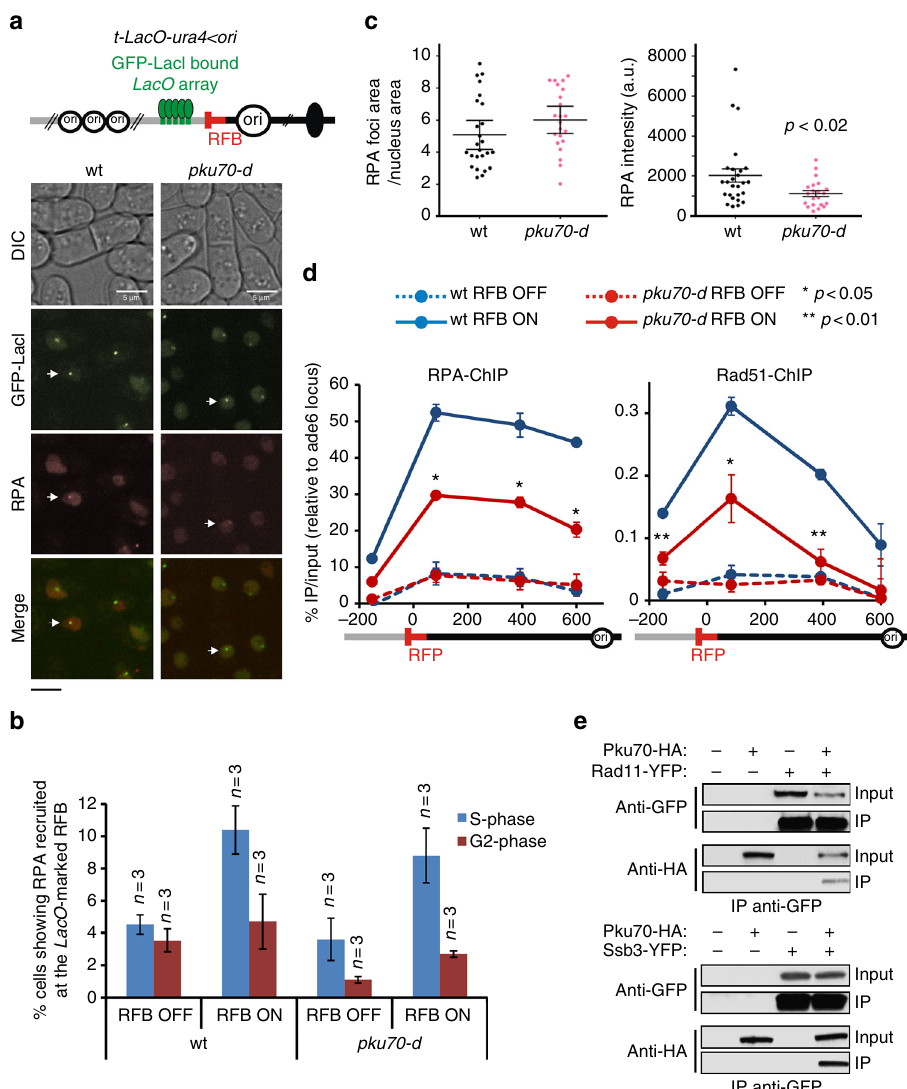
Fig. 7 The lack of Ku impairs RPA and Rad51 recruitment to terminally arrested forks. a Top panel: scheme of the LacO -marked RTS1 -RFB. Bottom panel: representative images showing RPA (labelled with Ssb3-mCherry) recruitment to the LacO -marked RFB. Of note, to avoid biases toward a random localization of GFP-LacI and RPA foci, cells with ≥ 3 RPA foci were excluded from the analysis. Scale bars correspond to 5 µ m. b % of cells showing RPA recruitment to the LacO -marked RFB, according to cell cycle phase. G2 and S-phase cells are mononucleated cells and bi-nucleated cells with a septum, respectively. Values are means of n samples from independent biological replicates ± SD. c Area and intensity of RPA foci recruited to the LacO -marked RFB. Each dot represents one RPA foci in S-phase upon RFB activation. Bars indicate the mean value ± 95% CI. Statistics were calculated using the non-parametric Mann-Whitney U test. d Analysis of RPA and Rad51 recruitment to the RTS1 -RFB by ChIP-qPCR in indicated strains and conditions. Upstream and downstream distances from the RFB are indicated in base pairs (bp). The values are the means of three to four samples from independent biological replicates ± SEM. Statistical analysis was performed using the Mann-Whitney U test. e Co-immunoprecipitation of Pku70-HA with two subunits of RPA, Rad11 and Ssb3, fused to the YFP epitope. Experiments were performed in the presence of benzonase. For a longer exposure,